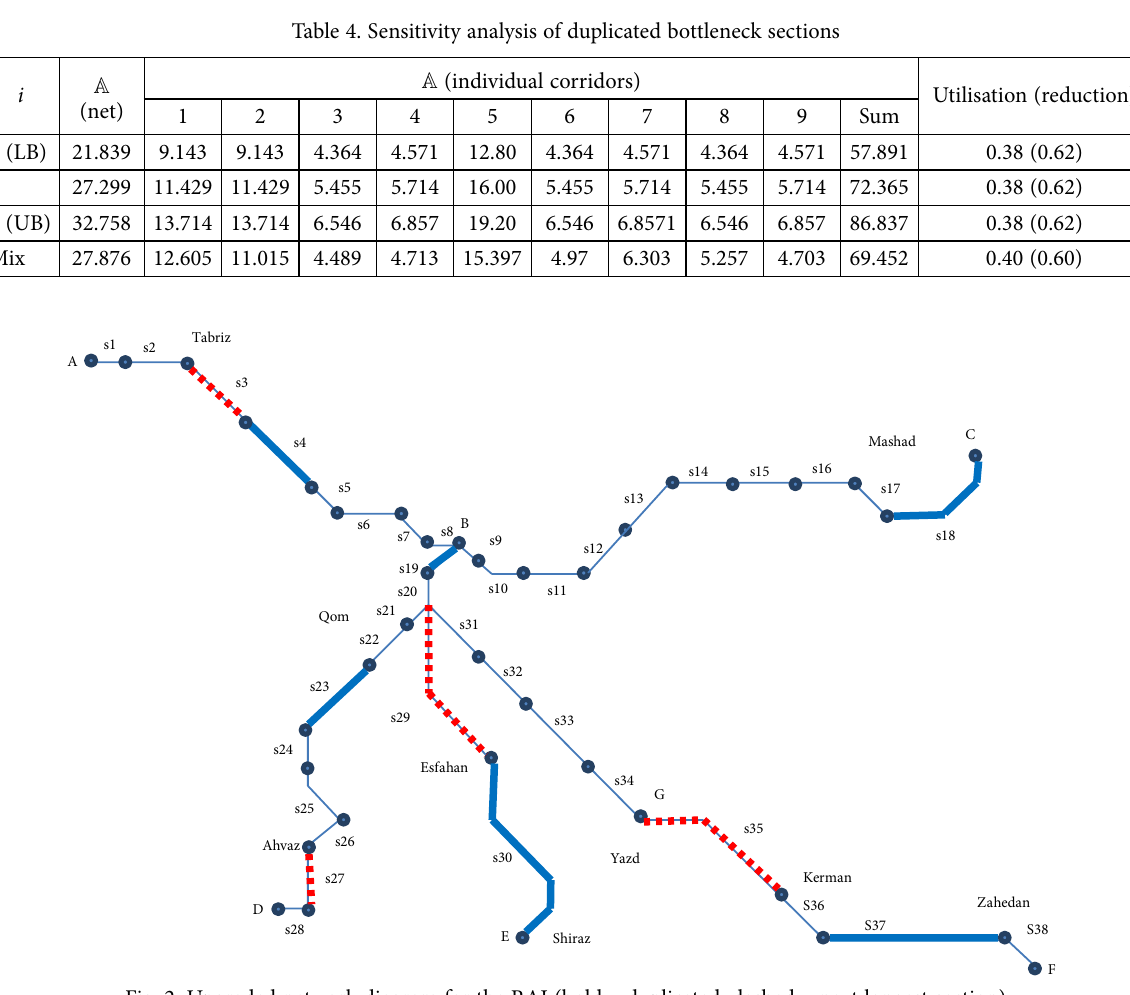
Fig. 2. Upgraded network diagram for the RAI (bold – duplicated, dashed – next